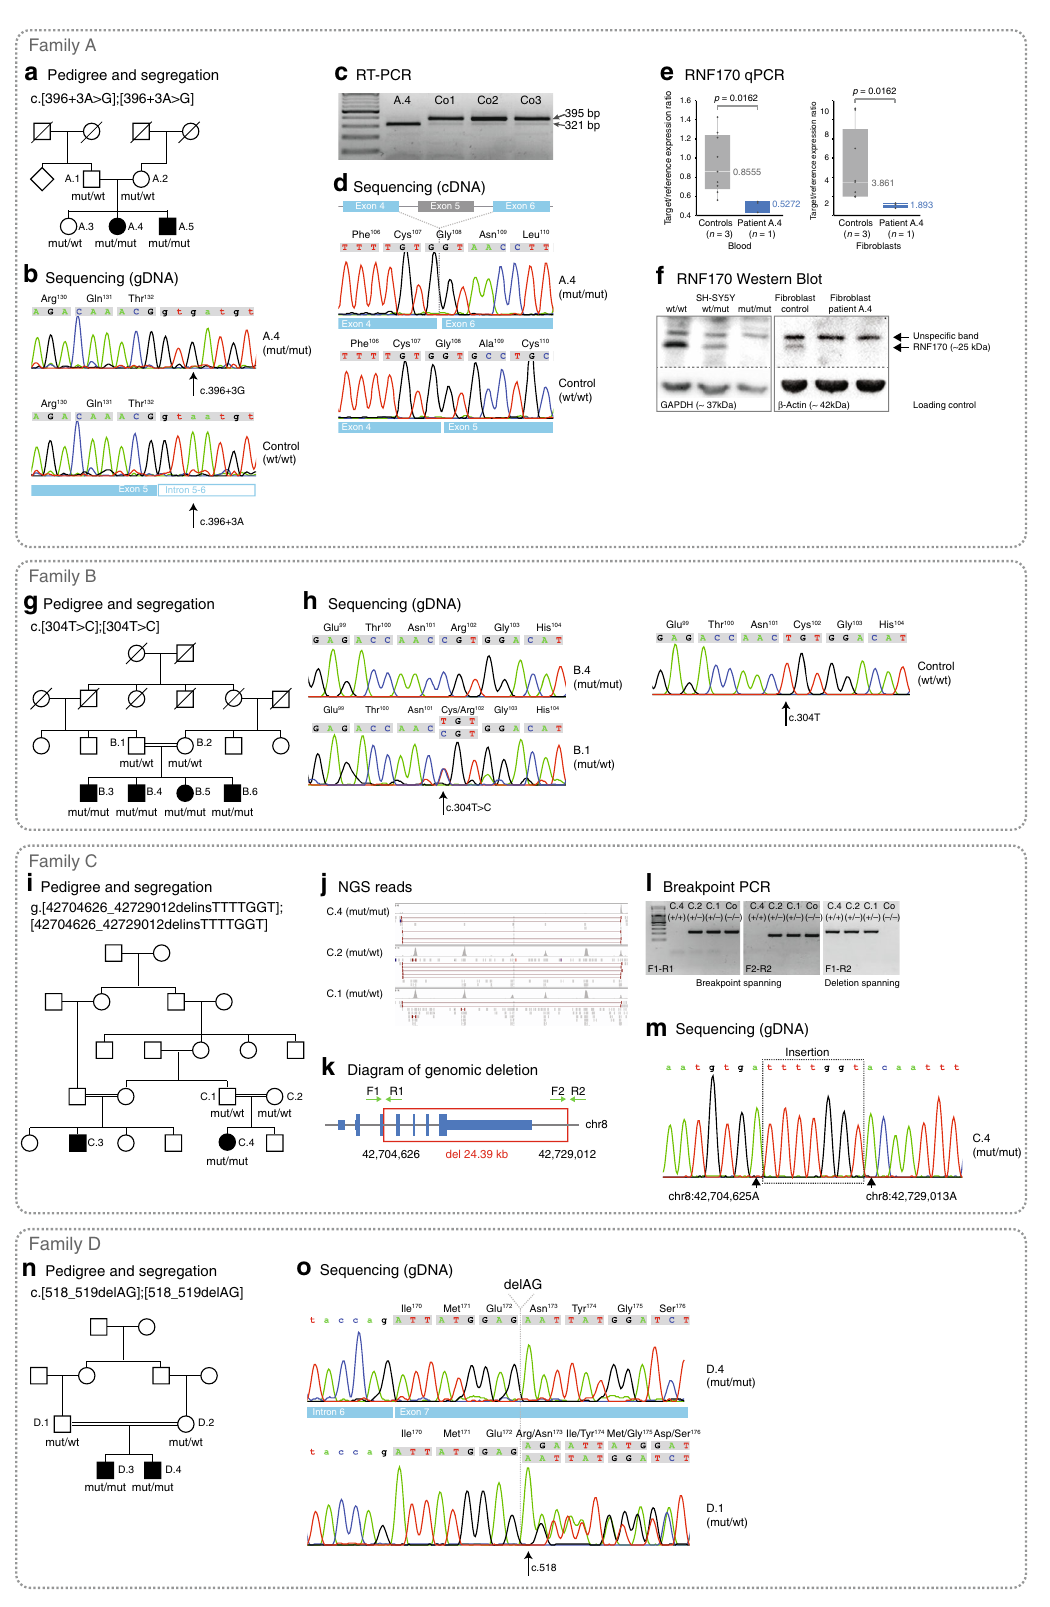
(Fig. 1n – o). The predicted protein, if expressed, lacks both C-terminal transmembrane domains. All mutations showed complete co-segregation with the phenotype in the respective families (Fig. 1, Table